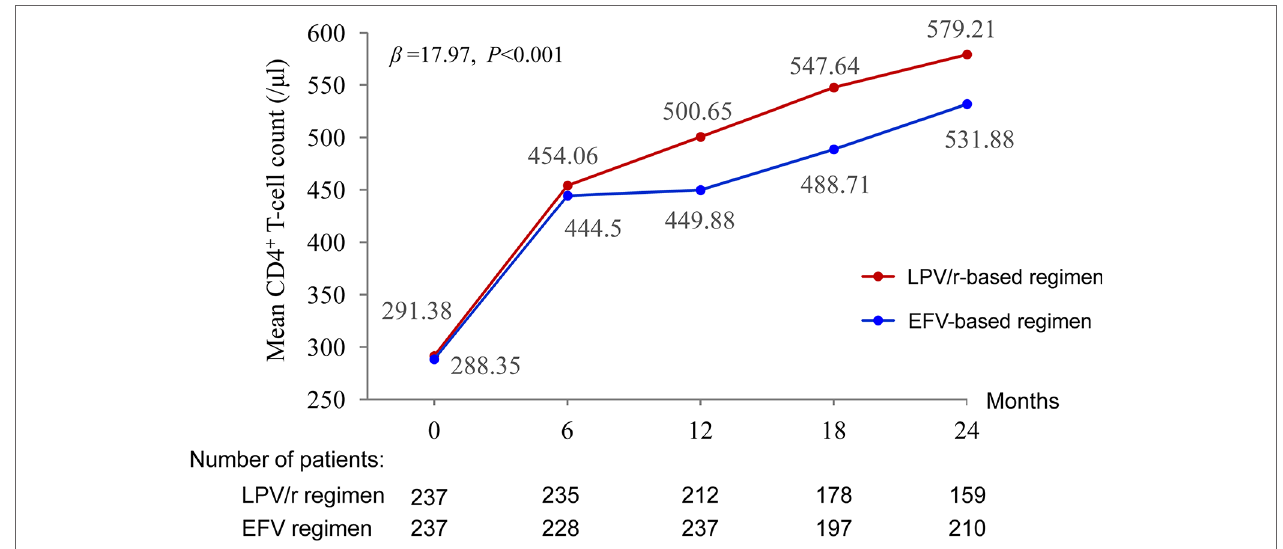
FIgURE 3 | Mean changes in the CD4 + T-cell counts of